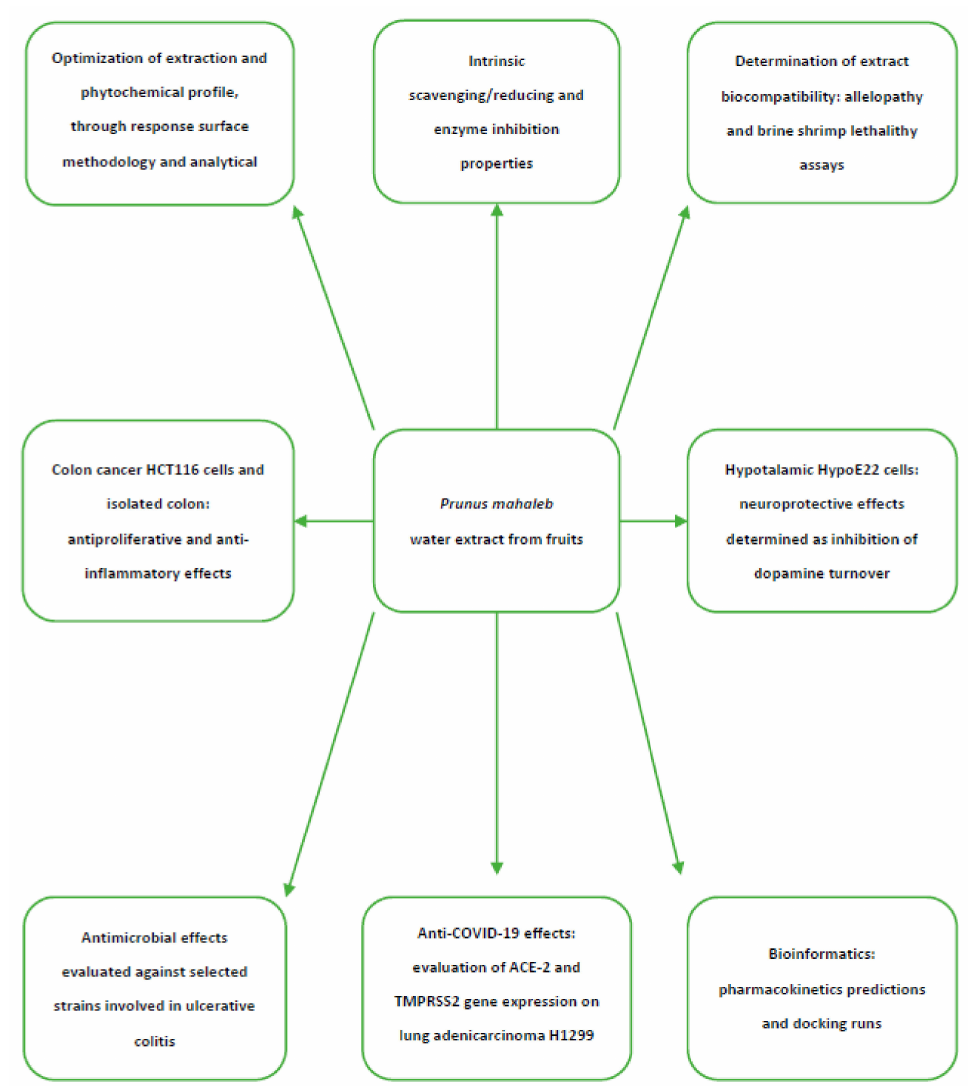
Figure 1. Schematic representation of the aims of the present